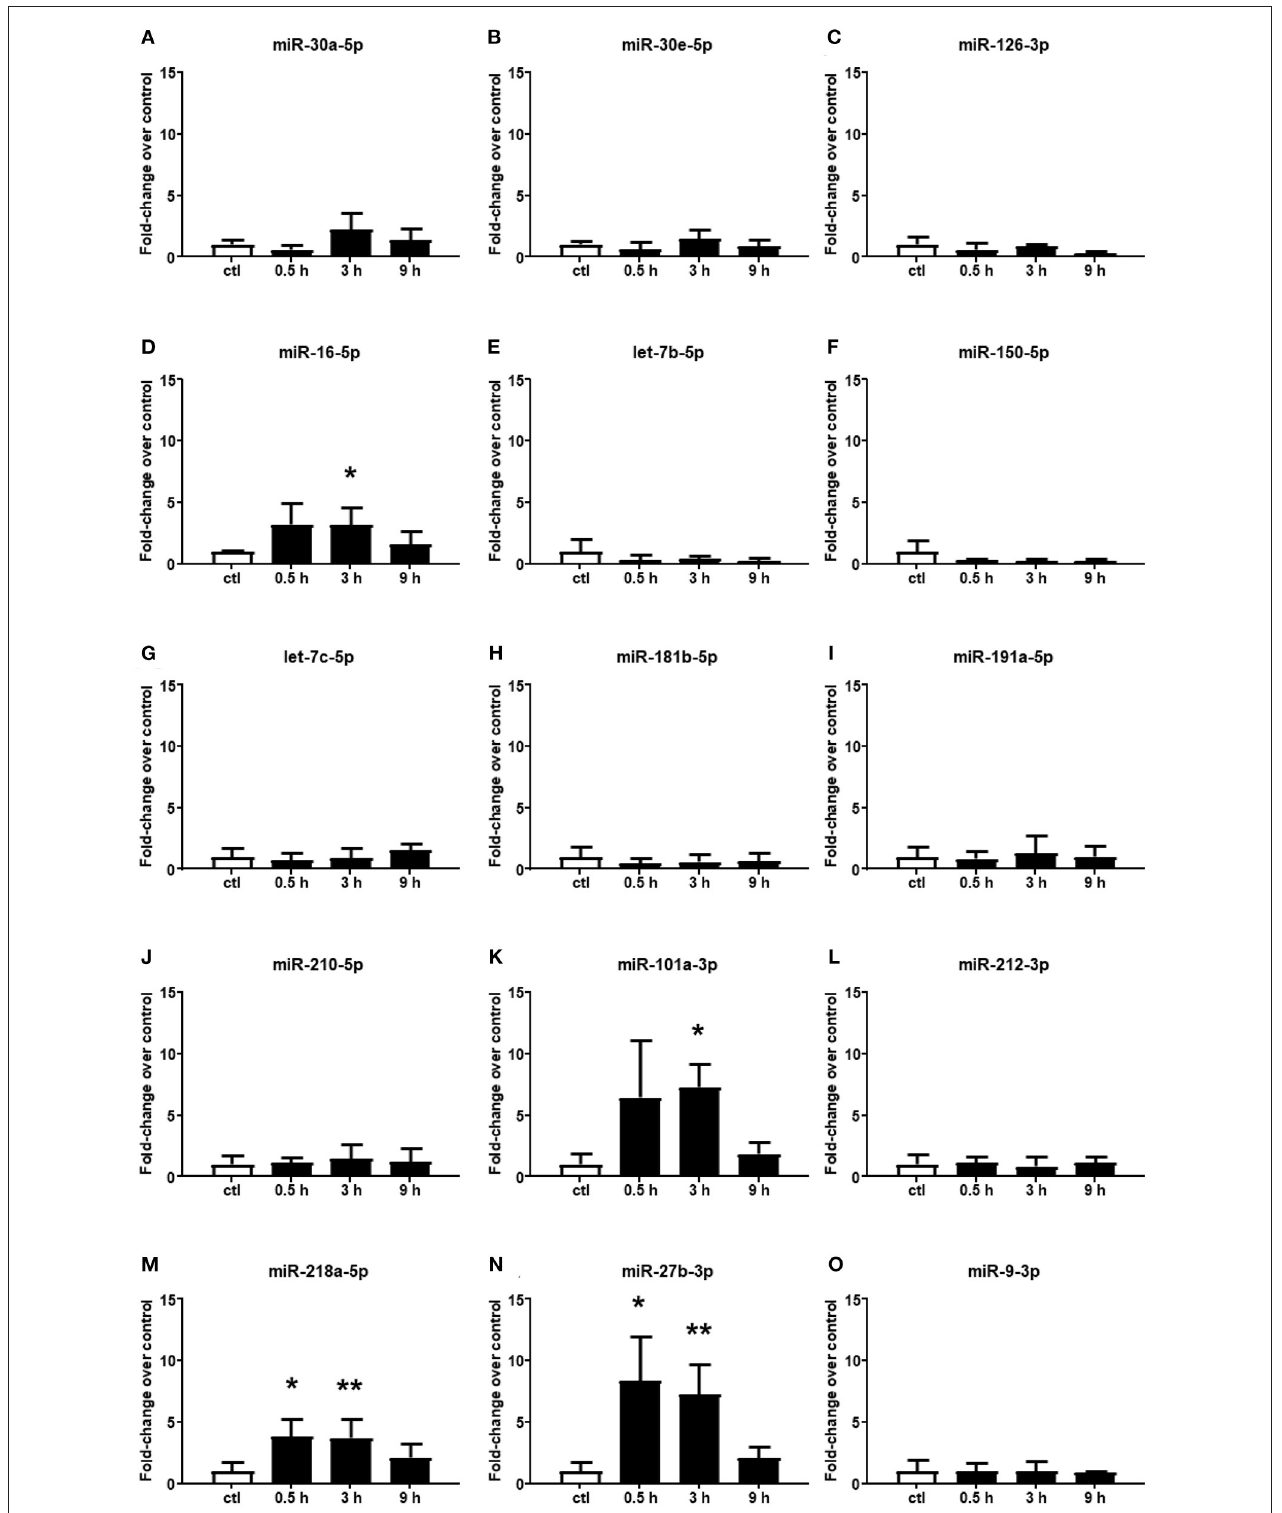
FIGURE 2 | Plasma microRNA expression analysis after permanent middle cerebral artery occlusion by real-time PCR. The microRNA levels analyzed by real-time PCR in plasma samples withdrawn from the tail vein of rats subjected to permanent middle cerebral artery occlusion are expressed as fold change over the control group. (A–O) indicate miRNAs evaluated. Each column represents the mean ± SD. The results of the microRNA expression were normalized with respect to U6 snRNA as the internal control. n = 3 or 4 per group. * p < 0.05 vs. control group. ** p < 0.01 vs. control group.